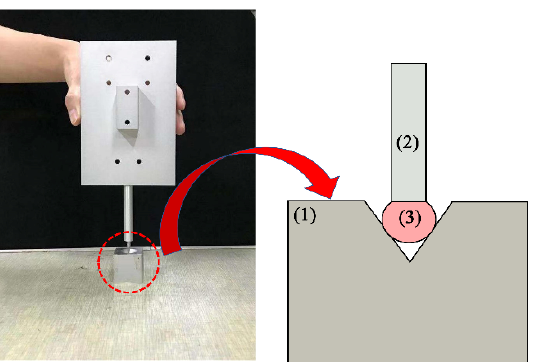
Figure 1. The principle of position invariance: (1) Object to be measured (2) Light pen stylus (3) stylus tip center.